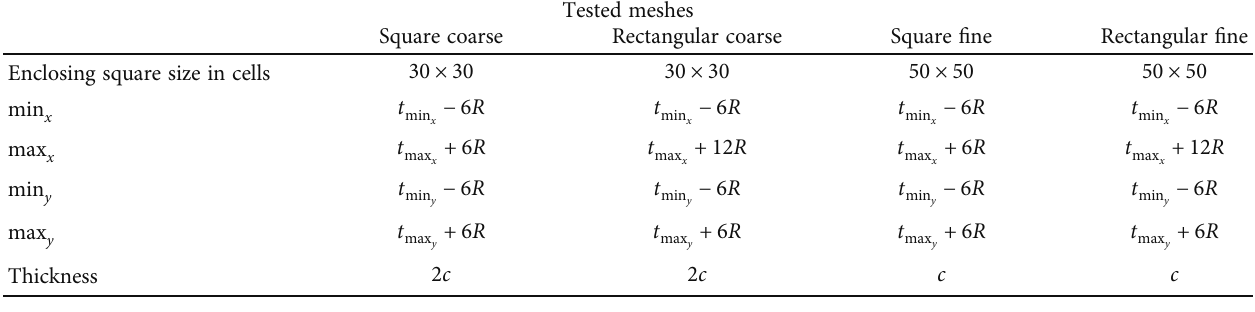
Table 2: Four kinds of meshes used for the sensitivity study of a wind farm. λ = 4 , U the leftmost turbine ’ s position.